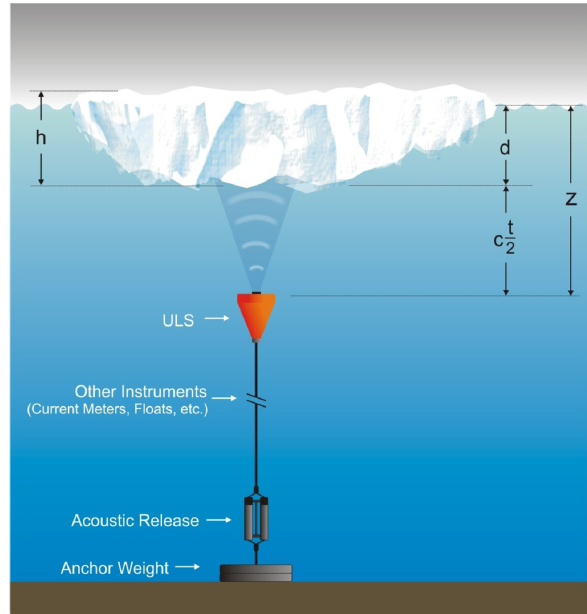
Figure 1. The ULS measurement principle. d : sea ice draft, z : in- strument depth, h : sea ice thickness, c : sound velocity, t : two-way travel